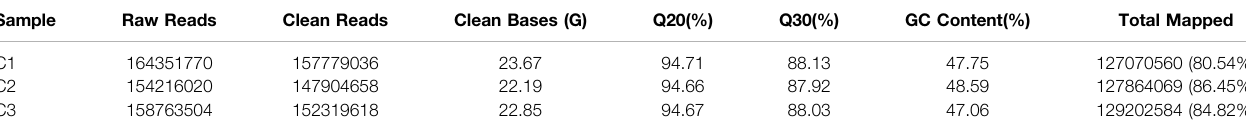
TABLE 1 | Statistical data of the RNA-seq reads for three development stages. Sample